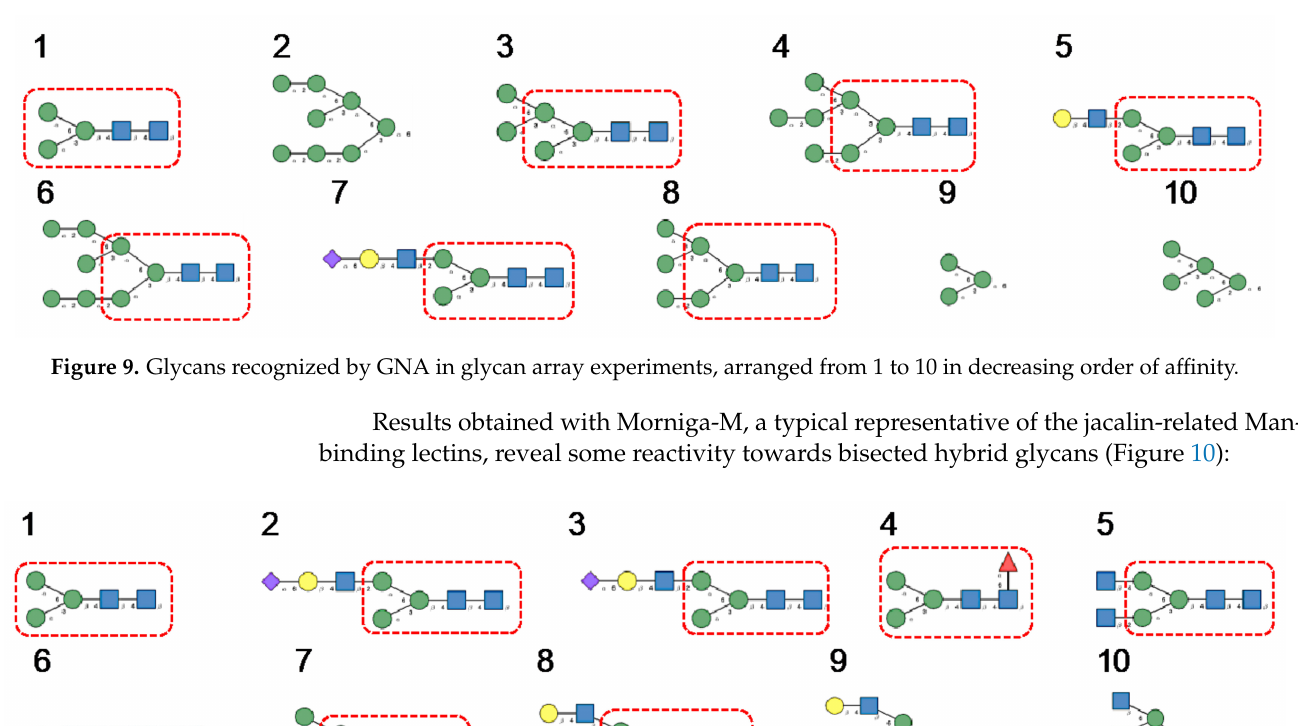
Figure 8. Glycans recognized by PsA in glycan array experiments, arranged from 1 to 10 in decreasing order of affinity. Glycan array results obtained for GNA, the Man-specific lectin from snowdrop, the prototype of monocot Man-binding lectins, are in decreasing order of affinity (Figure 9):